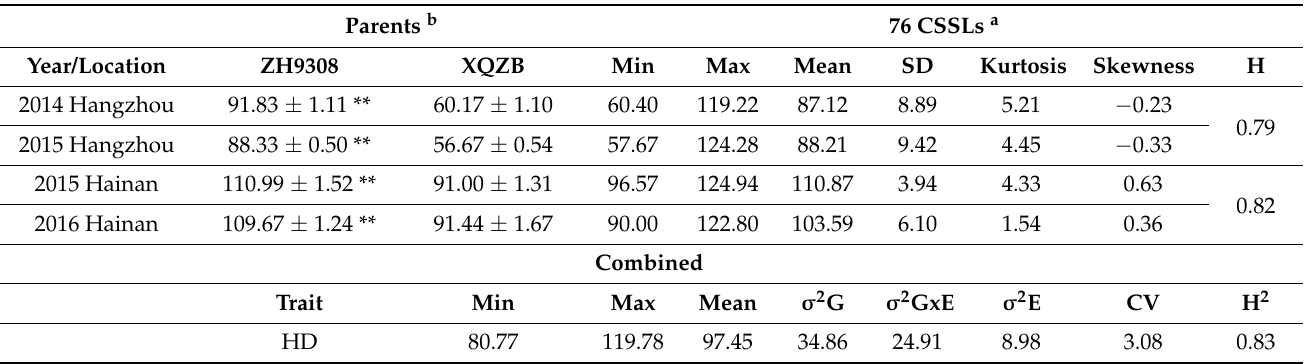
Table 1. Summary of heading dates of parents and 76 chromosome segment substitution lines (CSSLs) evaluated under two natural short-day conditions at Hainan and long-day conditions at